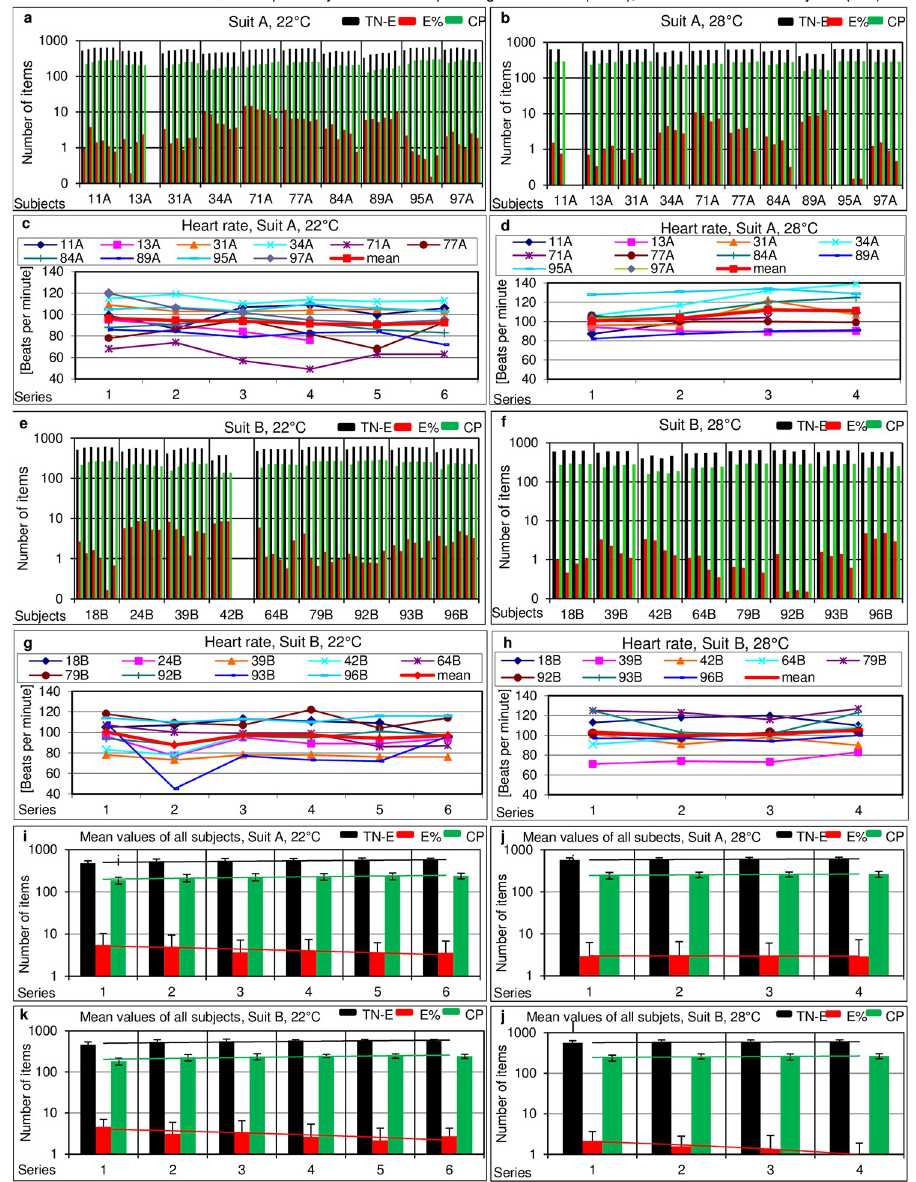
Fig 4. Results of the d2 test of attention. a, b, e, f: Y-axis: Graphs show TN-E (black bars), the amount of symbols recognized correctly, E% (red bars), the percentage of errors and CP (green bars), index of concentration performance. X-axis: Individual performance values of each subject performing six series at 22˚C with (a) suit A, (e) suit B and four tests at 28˚C (b) suit A and (f) suit B are divided by vertical lines. c, d, g, h: Courses of every individual´s heart rate corresponding to d2 test performances during the six or four tests, respectively. i, j, k and l: Mean values of all subjects calculated per test series including a trend line showing the average development of TN-E and E% in 6 series at 22˚C and 4 series at